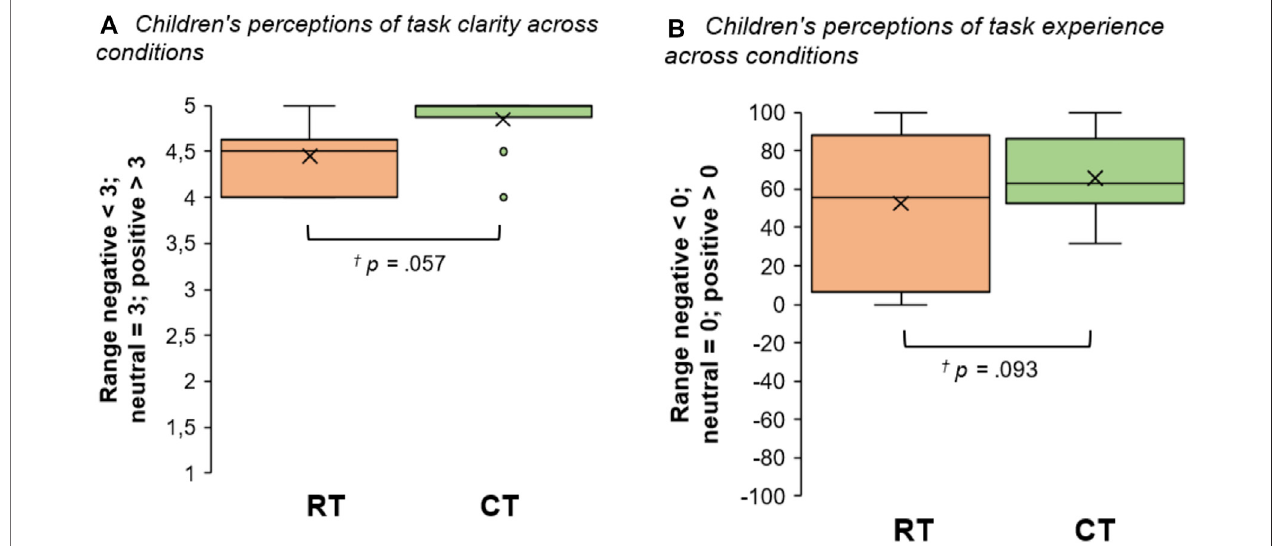
FIGURE 4 | Box plots showing children ’ s responses to (A) questionnaire items on task clarity, and (B) VAS items on how well the task worked, both across conditions (x = means; lines = medians; whiskers = ranges).